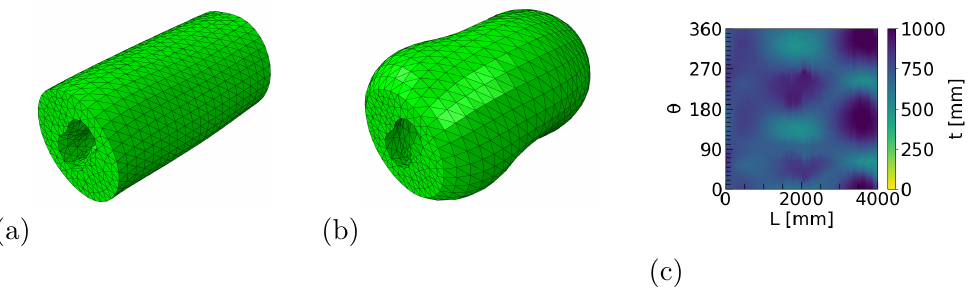
Figure 6. ( a ) Undeformed optimized geometry (stationary). ( b ) Deformed optimized geom- etry (rotating) with minimized cross-section roundness errors. ( c ) Wall thickness variation of optimized geometry.